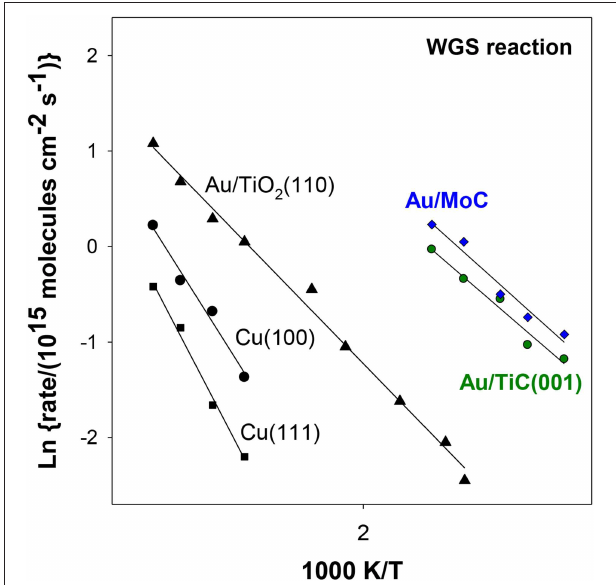
FIGURE 5 | Arrhenius plots for the LT-WGS reaction over copper, Au/oxide and Au/carbide surfaces. Reaction conditions: 10 Torr of H 2 O and 20 Torr of CO. Data taken from Si et al. (2012), Rodriguez et al. (2014), and Posada-Perez et al. (2017).